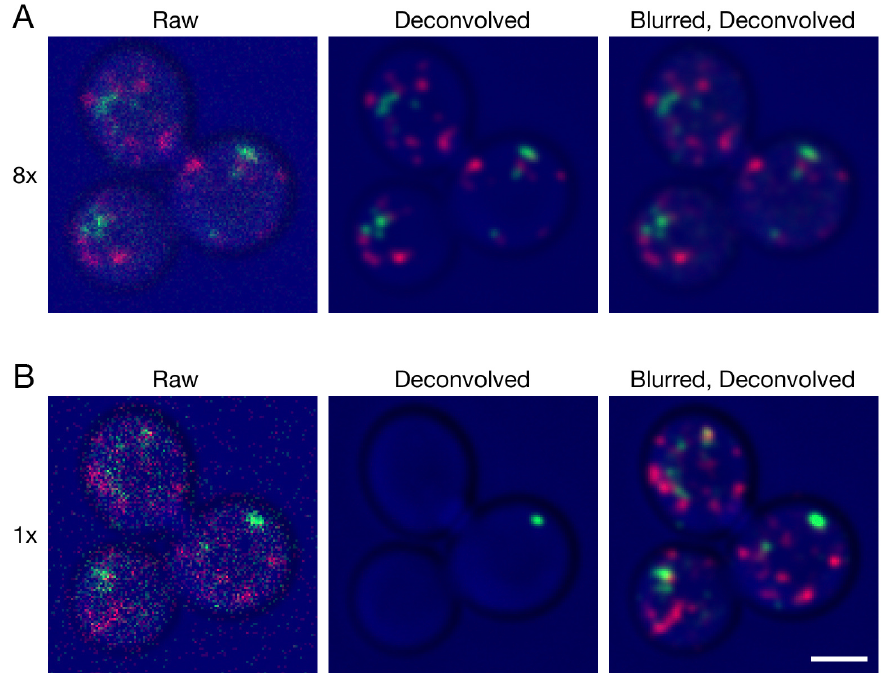
Figure 1. Improved deconvolution of 4D live cell data with a Gaussian blur prefilter. Gene replacement in Saccharomyces cerevisiae was used to label late Golgi cisternae with Sec7-mCherry (red) and prevacuolar endosomes with Vps8-GFP (green) (Papanikou et al ., 2015). Cells were imaged by 4D confocal microscopy. In consecutive movies, line accumulation was set to ( A ) 8x or ( B ) 1x. The data were average projected either with no processing, or after deconvolution with Huygens, or after prefiltering with a 2D Gaussian blur using a radius of 0.75 pixels followed by deconvolution. Fluorescence data are superimposed on differential interference contrast images of the cells (blue). Shown are representative frames from Video 1 (8x) and Video 2 (1x). The fluorescence patterns in ( A ) and ( B ) are similar, but not identical because the labeled structures changed during the interval between the two movies. Scale bar, 2